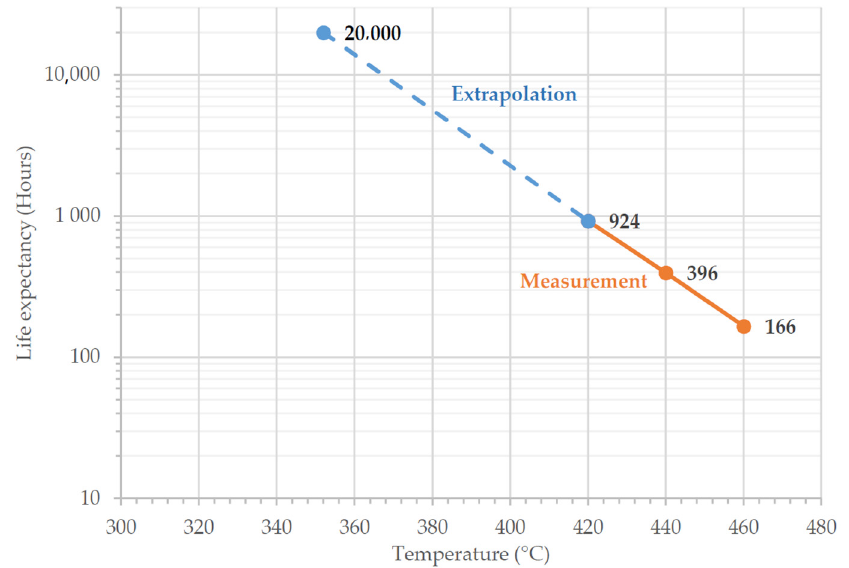
Figure 9. Thermal endurance graph of the anodized strip.